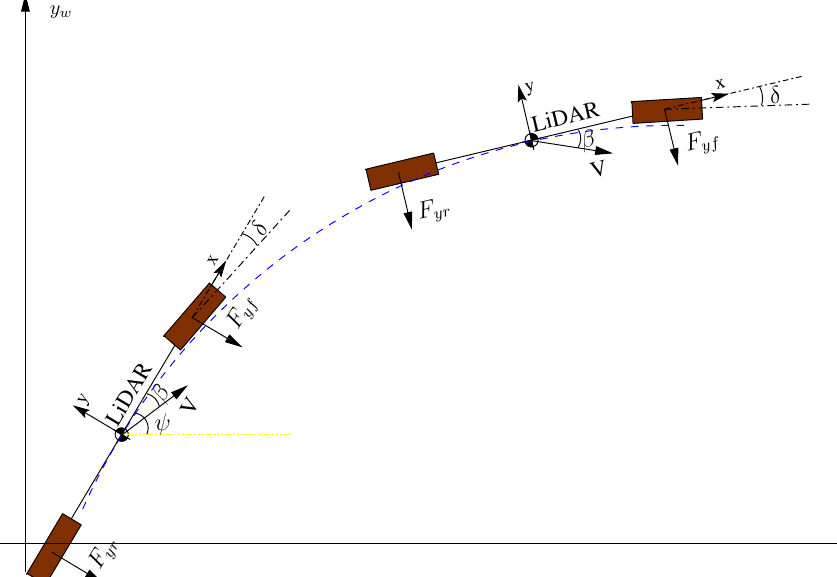
Figure 2. Vehicle representation by bicycle model. Using the vehicle reference system, our LiDAR-based odometry process assesses the vehicle forces between two instants of time, allowing for estimation of the β and δ